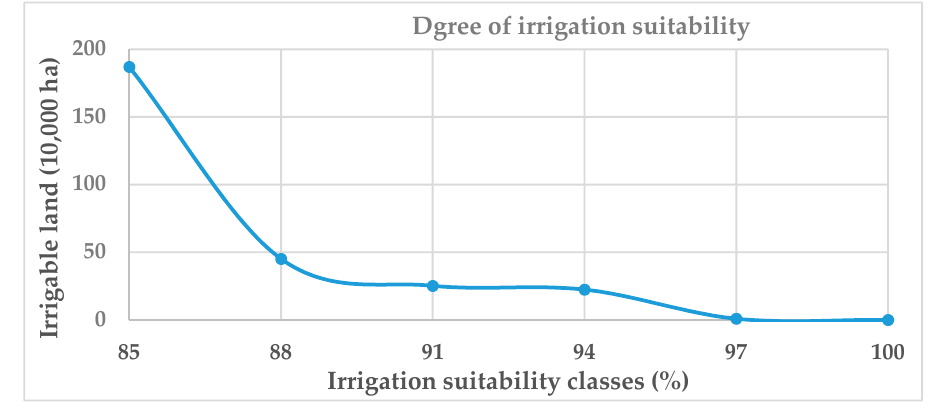
Figure 5. Degree of irrigation suitability for the potentially irrigable land.